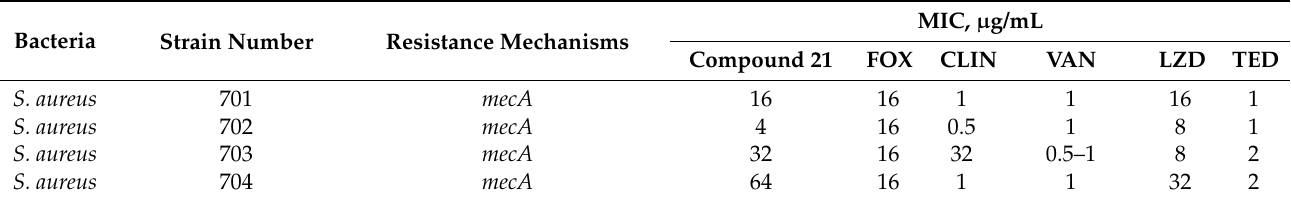
(Table 3). Compound 21 demonstrated higher antimicrobial activity against Gram-positive pathogens ( C. difficile and C. perfringens ). The weak activity was also observed against Gram-negative pathogens, suggesting that under anaerobic conditions, compound 21 could confer some weak activity against Gram-negative anaerobic bacteria. Compound 21 did not exhibit greater activity than metronidazole, which was used as a control agent. Table 2. The antimicrobial activity of 5-oxopyrrolidine derivative 21 against linezolid/tedizolid- resistant Staphylococcus aureus strains. The data expressed in the table represents minimal inhibitory concentration from 3 technical replicates.